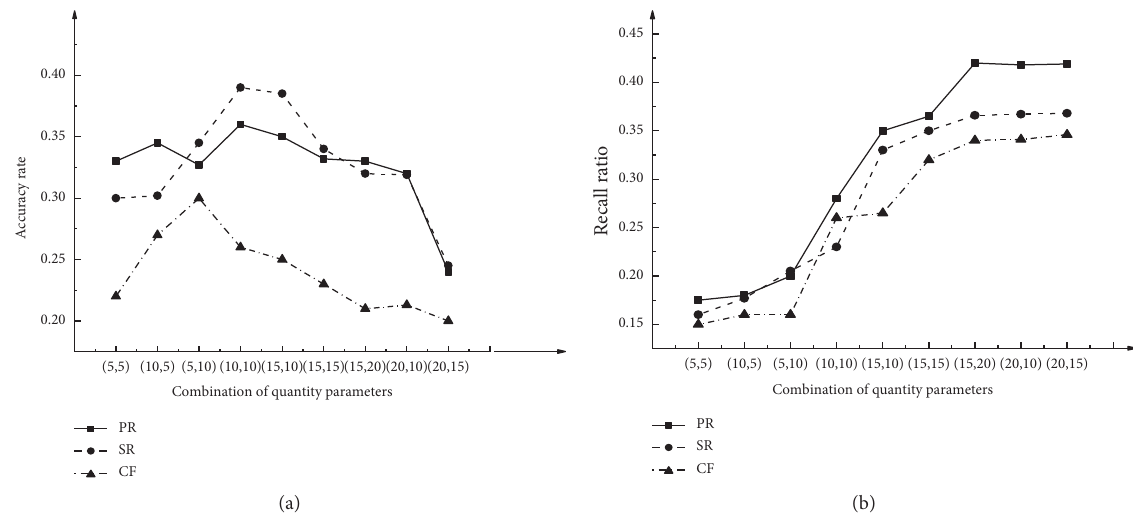
Figure 2: Distribution changes under several MOOC learning recommendation methods: (a) accuracy; (b) recall